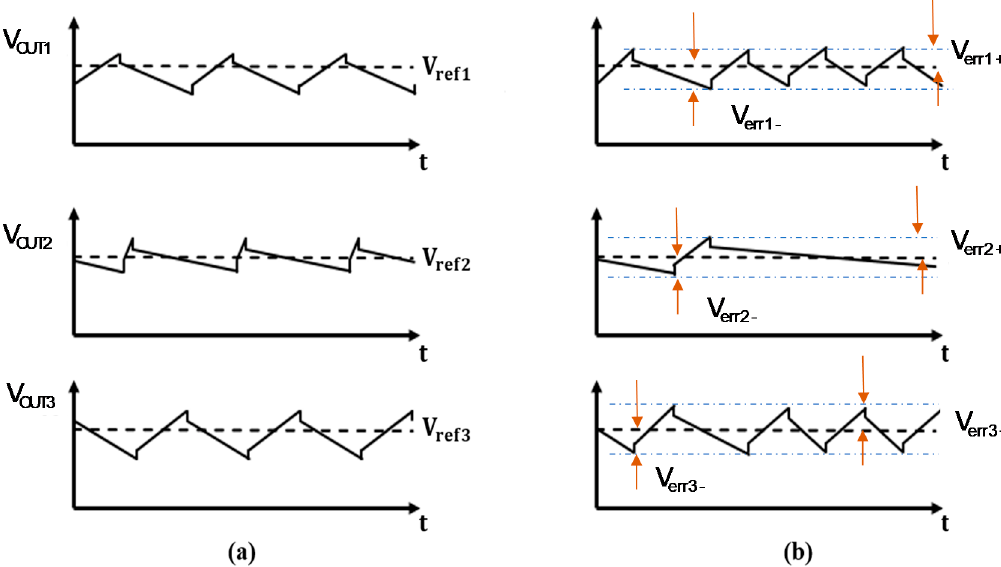
Figure 1. Illustrated example waveforms of output voltage of a single inductor multiple output (SIMO) converter with three outputs. Control scheme utilizing ( a ) sequential-order-based output selection [6,7,19,20], and ( b ) error-based output selection of [14].